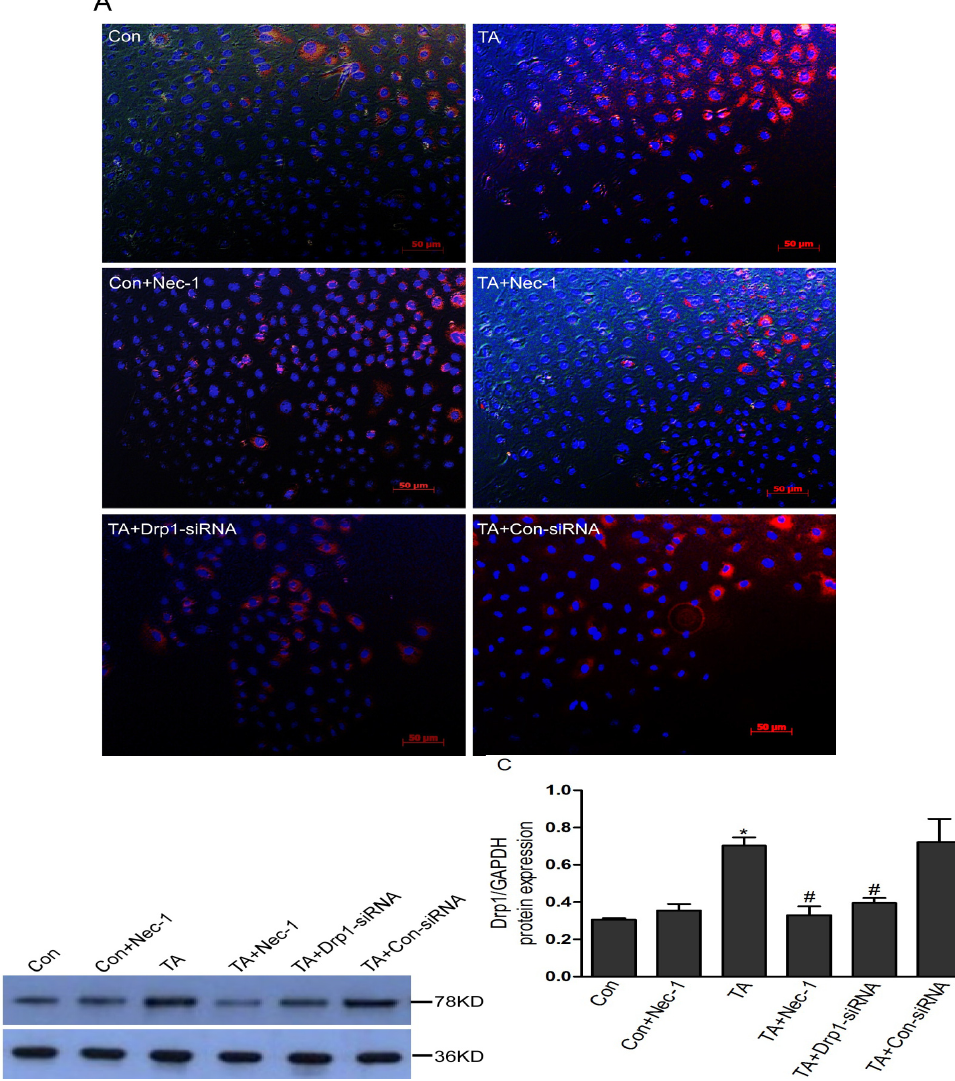
Figure 4. Effects of Nec-1 and Drp1 gene knock down on the protein expression of Drp1 in NRK-52E cells treated with TNF- α stimulation and ATP depletion. ( A ) Confocal images of NRK-52E cells showing expression of Drp1 (red) and DAPI-stained nuclei (blue); ( B ) Nec-1 treatment decreased the expression of Drp1 detected by immunoblot in an extract of stimulated ischemia injury of NRK-52E cells with TNF- α stimulation and ATP depletion; ( C ) Densitometric analysis of three repetitions of the experiment shown in ( C ). Values are expressed as the mean ± SEM. * p < 0.01 vs. Con; # p < 0.01 vs. TA. Ischemia injury increased the protein expression of Drp1 in NRK-52E cells, and the effect was blocked by either Nec-1, a specific inhibitor of necroptosis, or Drp1